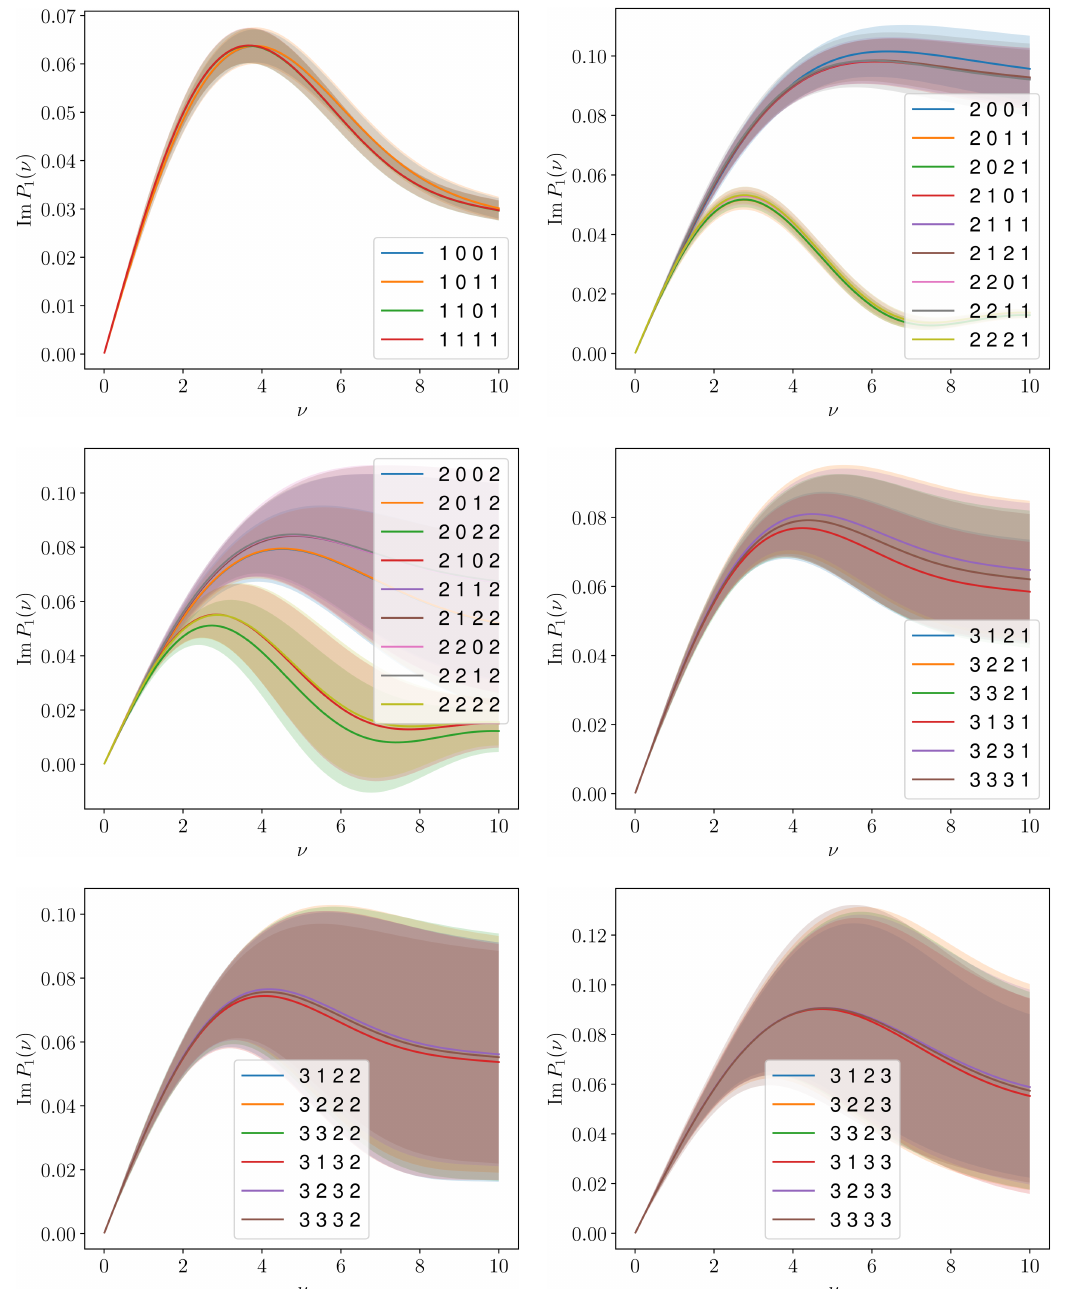
Figure 29 . The higher twist term, B 1 , results from fitting the imaginary component to the models. The numbers in the legend correspond to ( N ± , N